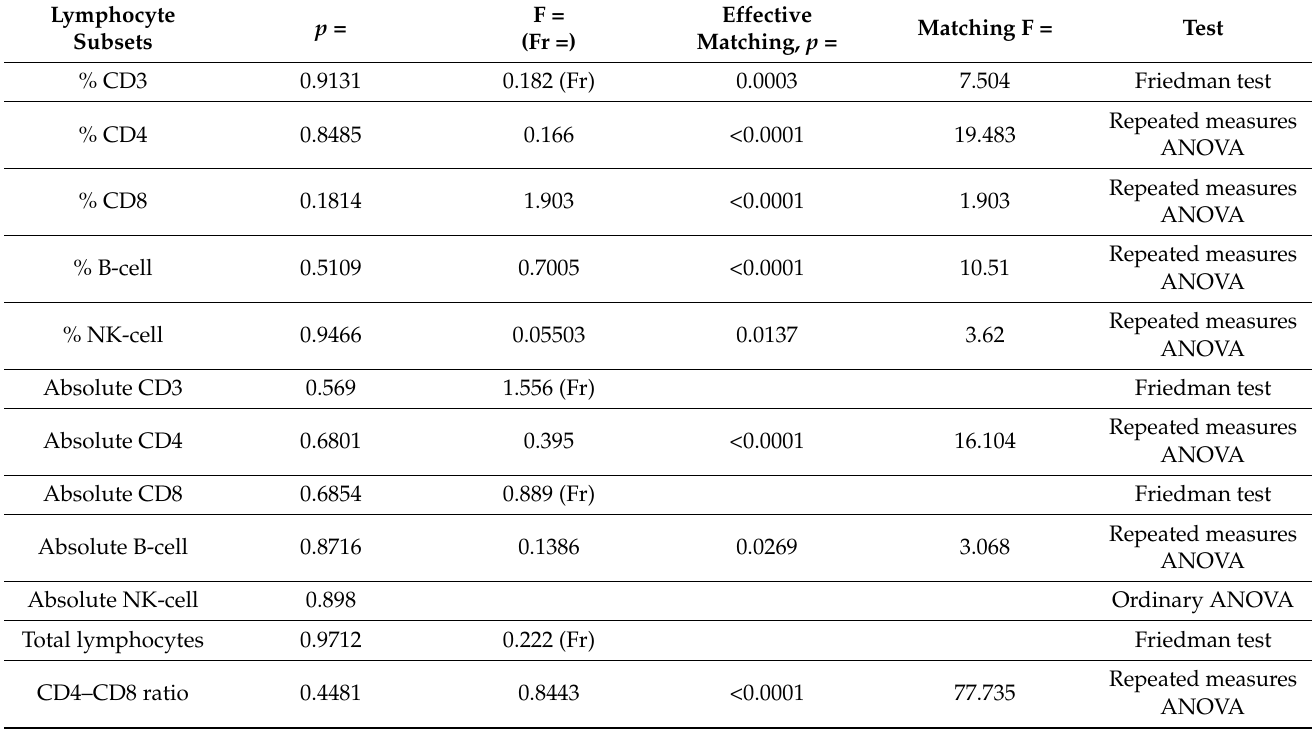
Table A1. ANOVA of flow-cytometry derived lymphocyte counts per timepoint.